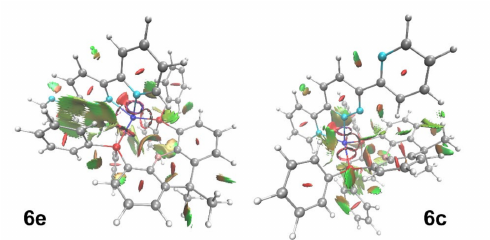
Figure 2. Non-covalent interactions in the optimized structures of 6 . 6e is experimental orientation determined by XRD; 6c is abnormal orientation calculated by DFT. Color legend: van der Waals interactions green, steric effect red, hydrogen bonding